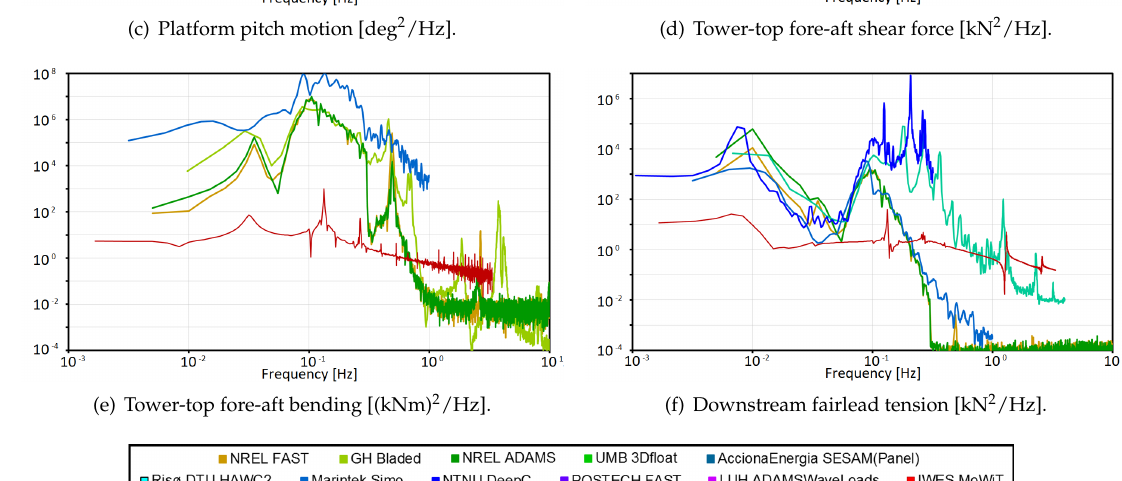
Figure 13. Hydro-elastic power spectra with irregular waves from LC